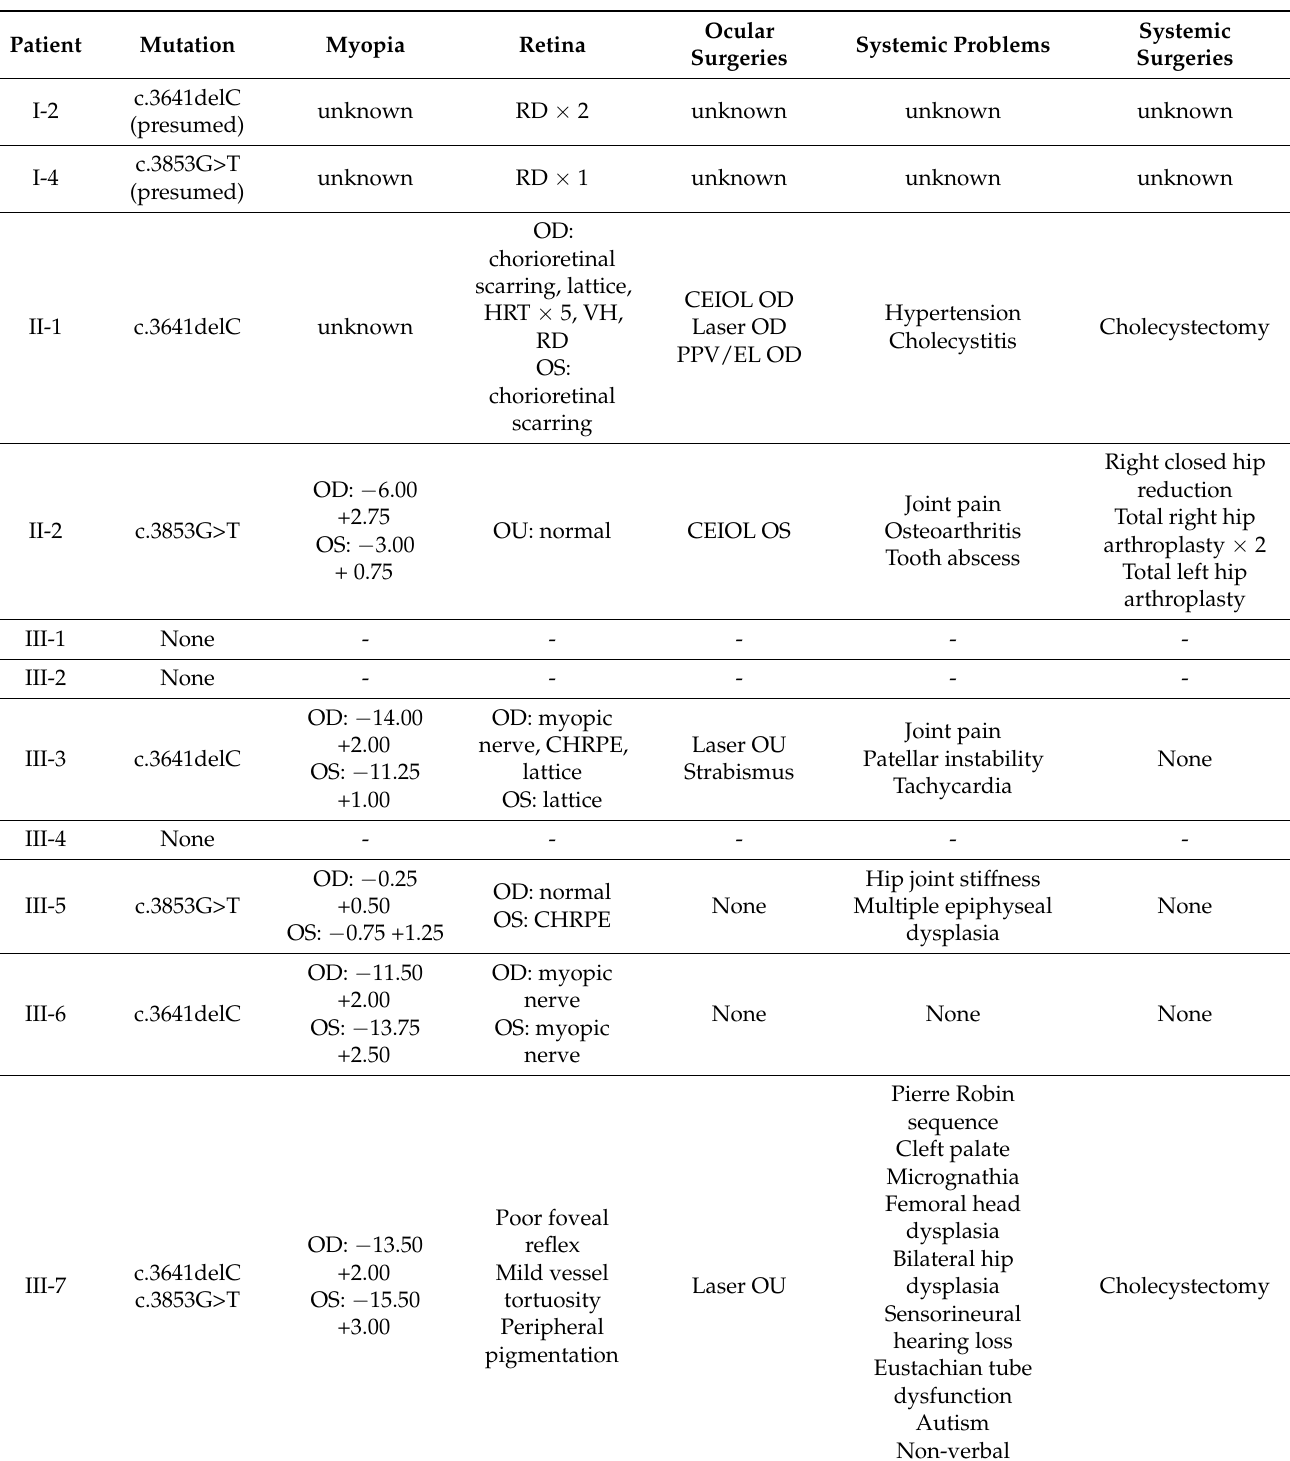
Table 1. Ocular and systemic characteristics in family members with Stickler syndrome type I Clinical findings of the eight patients with Stickler syndrome show the phenotypic variability with the family of interest, including ocular, systemic, and genetic